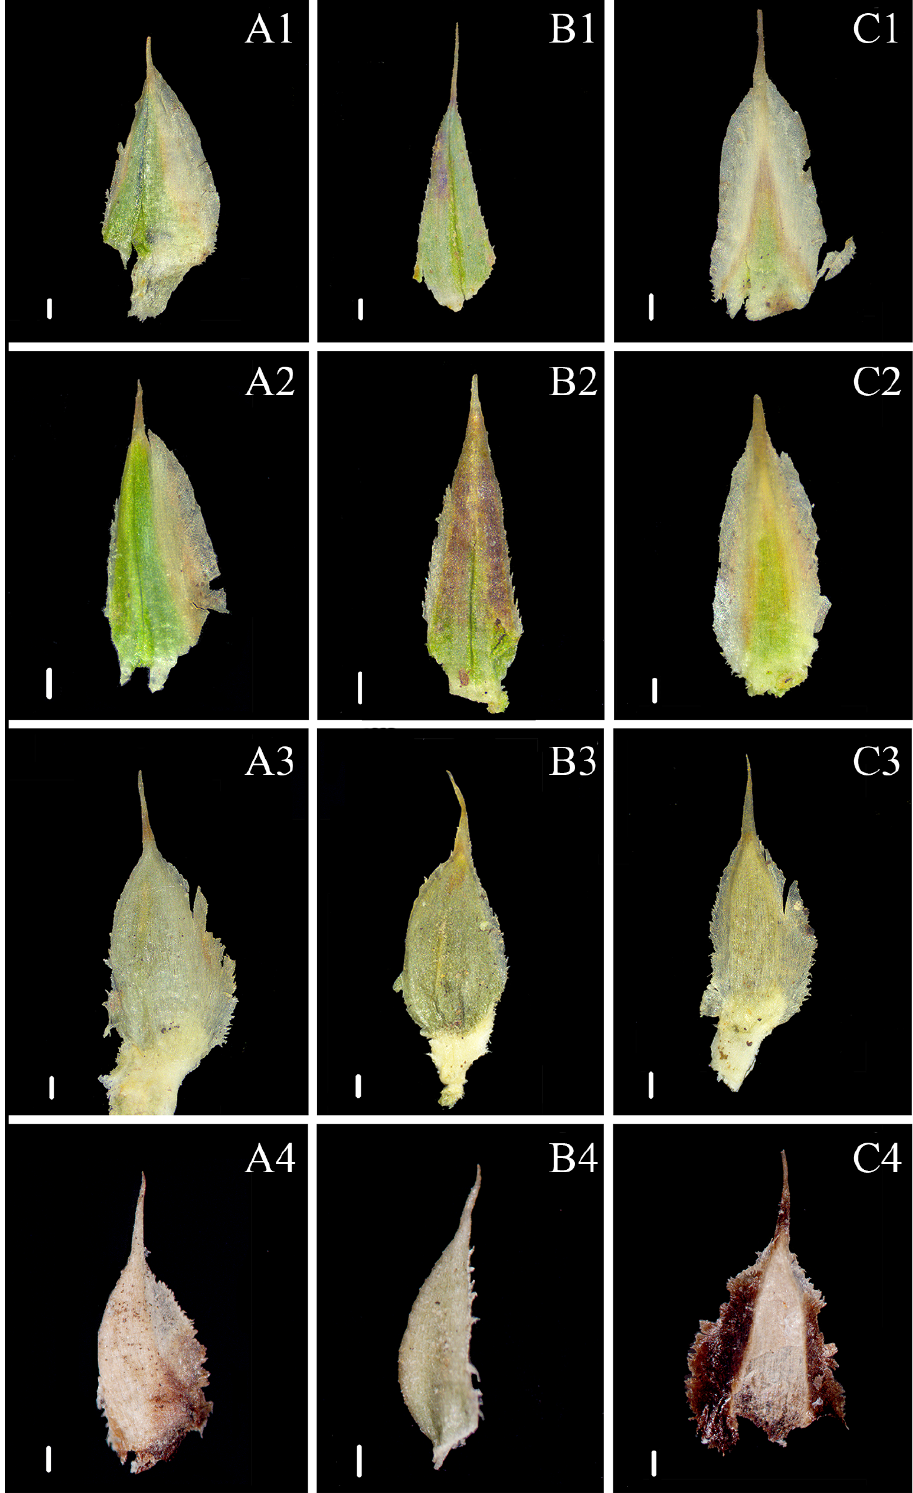
Figure 4. Comparison of leaf morphology of Selaginella iridescens , S. pseudotamariscina , S. tamariscina , and S. pulvinata . ( A1 – C1 ): S. iridescens , Hainan, Y. R. Wang, wyr20200110 (PE); ( A2 – C2 ): S. pseudotamariscina , Vietnam, C. W. Chen, Wade 5314 (PE); ( A3 – C3 ): S. tamariscina , Hainan, H. Y. Liang 63,716 (PE); ( A4 – C4 ): S. pulvinata , Yunnan, X. C. Zhang 088 (PE). A. ventral leaves; B. dorsal leaves; C. axillary leaves. Scale bars = 0.2 mm.